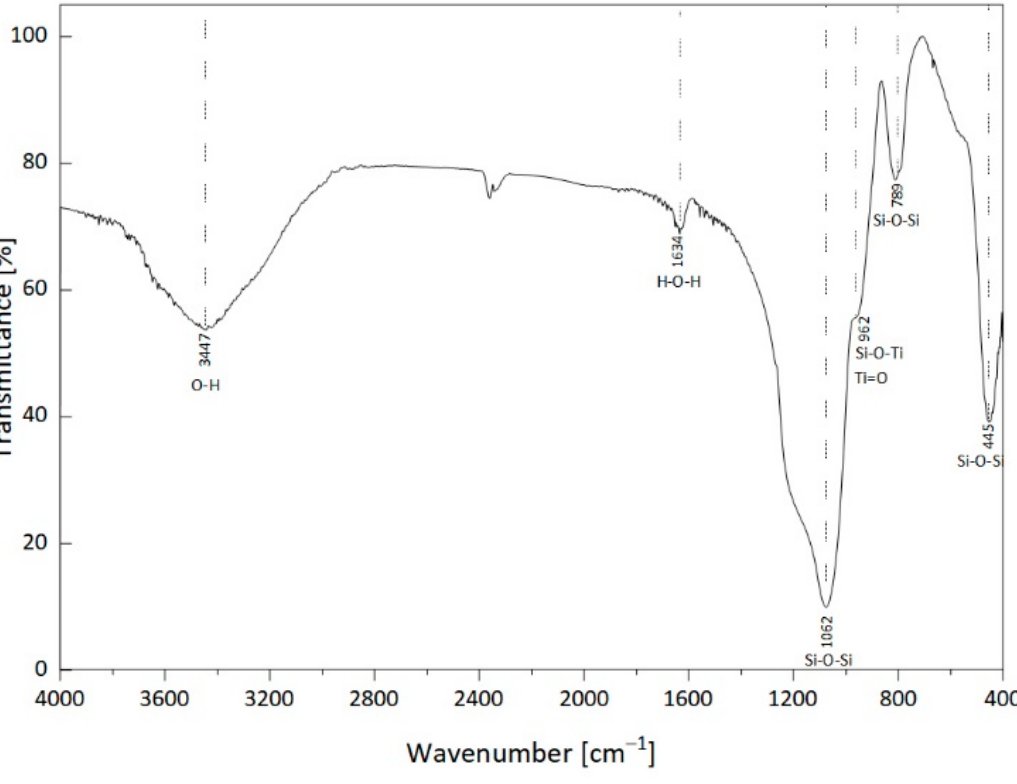
Figure 8. FTIR spectrum of the Ti-SBA-16 material.